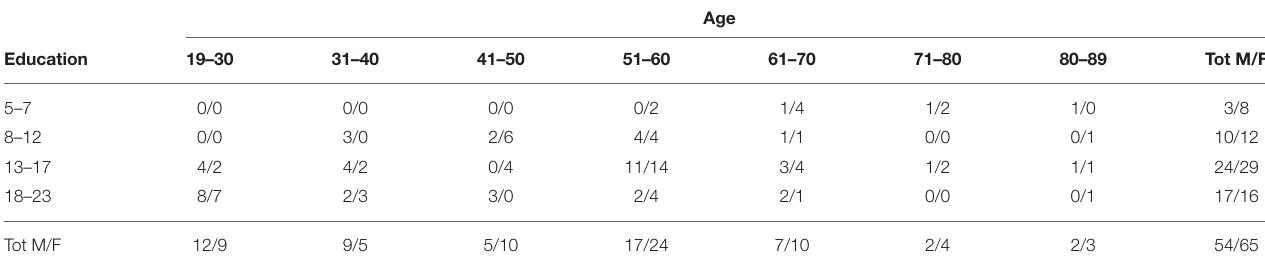
TABLE 1 | Distribution of Age, Education, and Gender for the 119 healthy participants of APACS normative data.